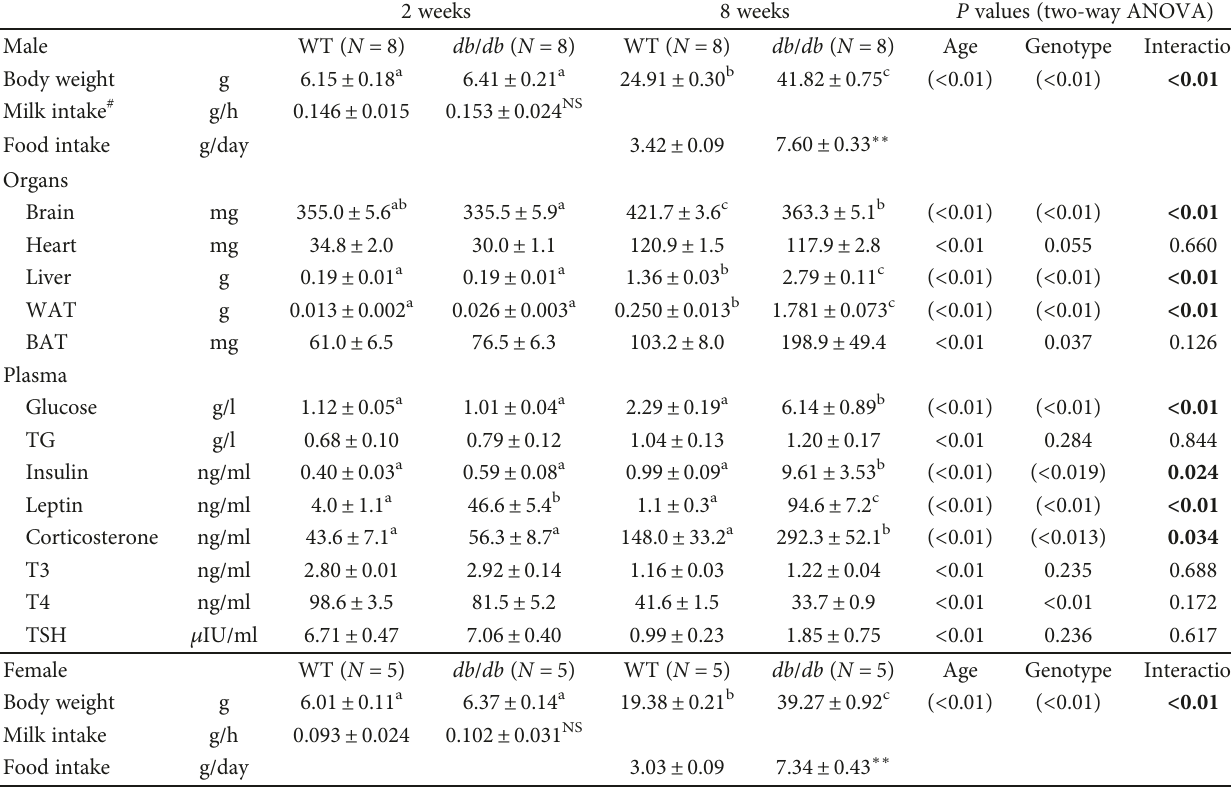
Table 2: Organ weight and biochemical parameters including hormones at 2 and 8 weeks.